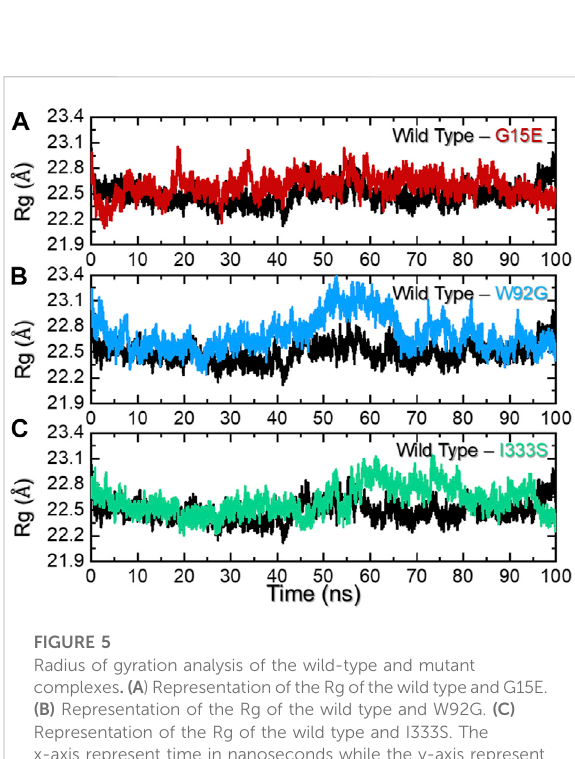
FIGURE 5 Radius of gyration analysis of the wild-type and mutant complexes .(A )RepresentationoftheRgofthewildtypeandG15E. (B) Representation of the Rg of the wild type and W92G. (C) Representation of the Rg of the wild type and I333S. The x-axis represent time in nanoseconds while the y-axis represent Rg in (cid:1)